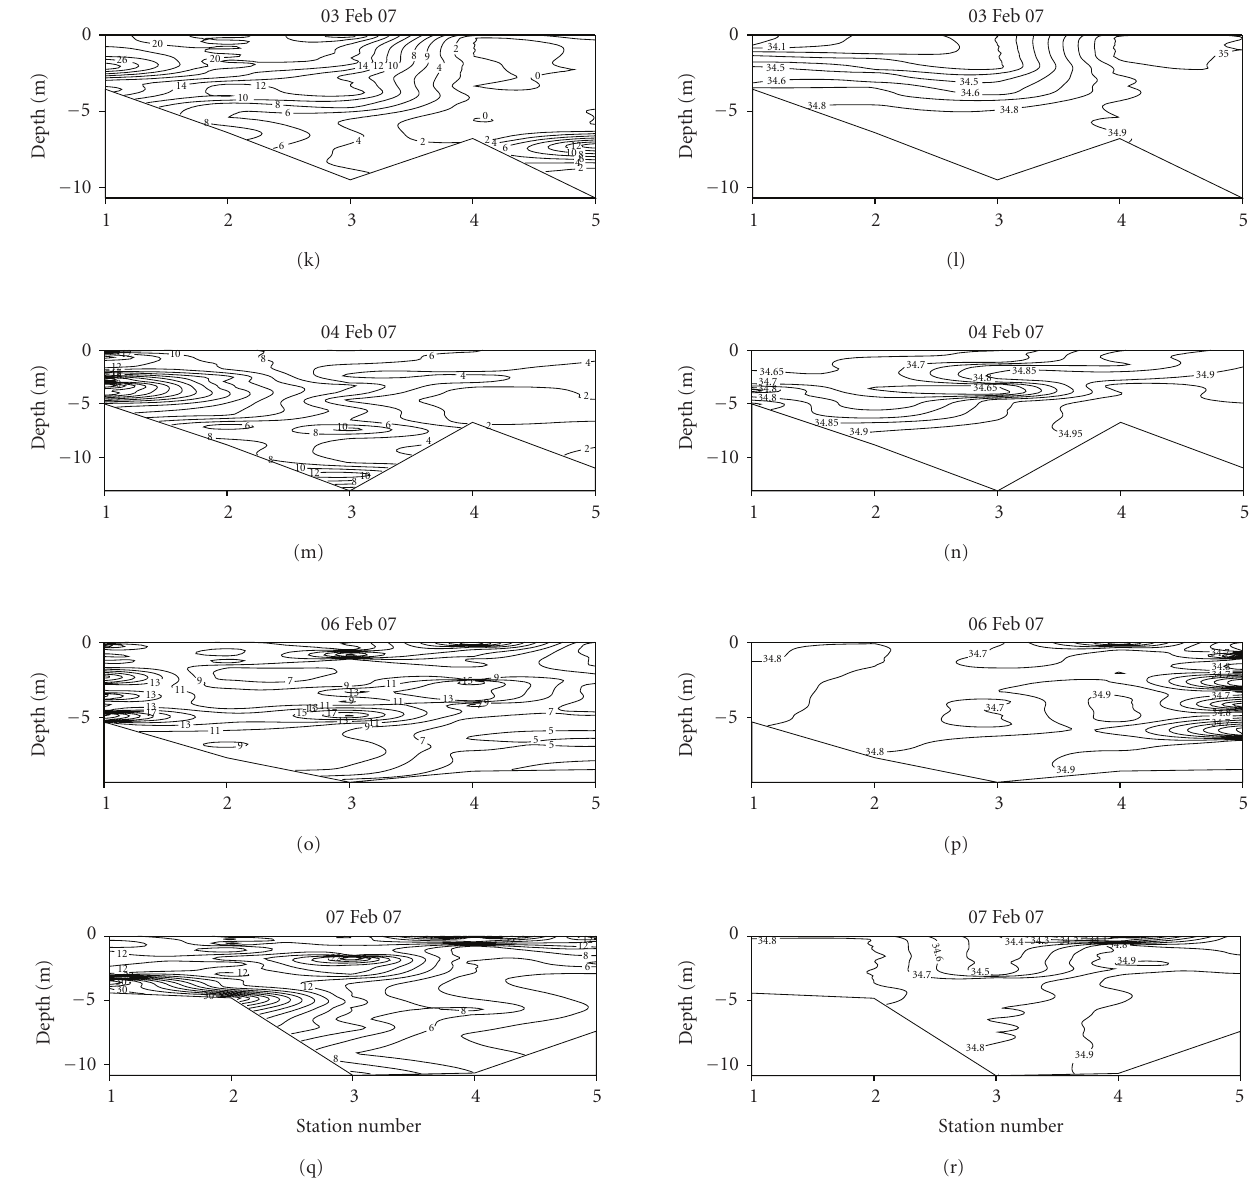
Figure 7: Snapshots at daily intervals of the two-dimensional distribution along the channel of salinity and SSC at Ngerikiil from CTD casts. The bottom line indicates the sea